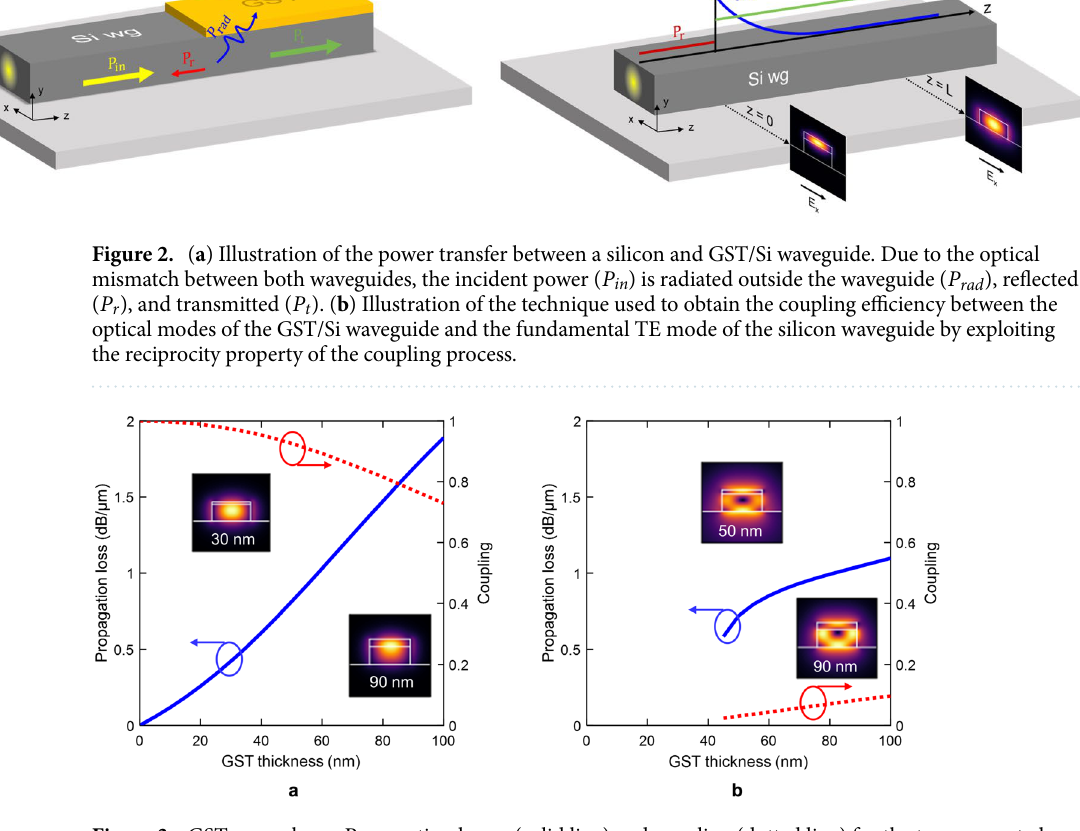
Figure 3. GST amorphous. Propagation losses (solid line) and coupling (dotted line) for the two supported optical modes: ( a ) fundamental GST TE-like (mode 0) and ( b ) hybrid (mode 1). Insets show the electric-field distribution | E | for a certain GST